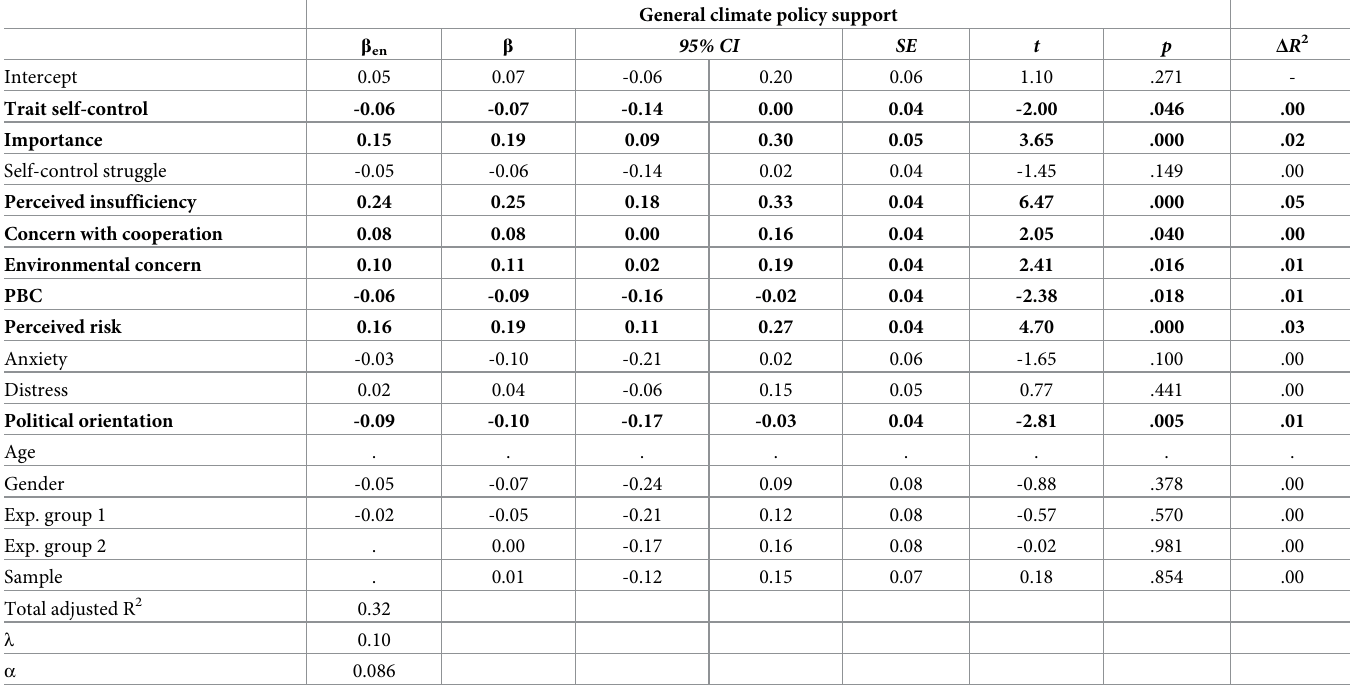
Table 2. Results of five-fold cross-validated elastic net regression and a multiple linear regression model predicting general climate policy